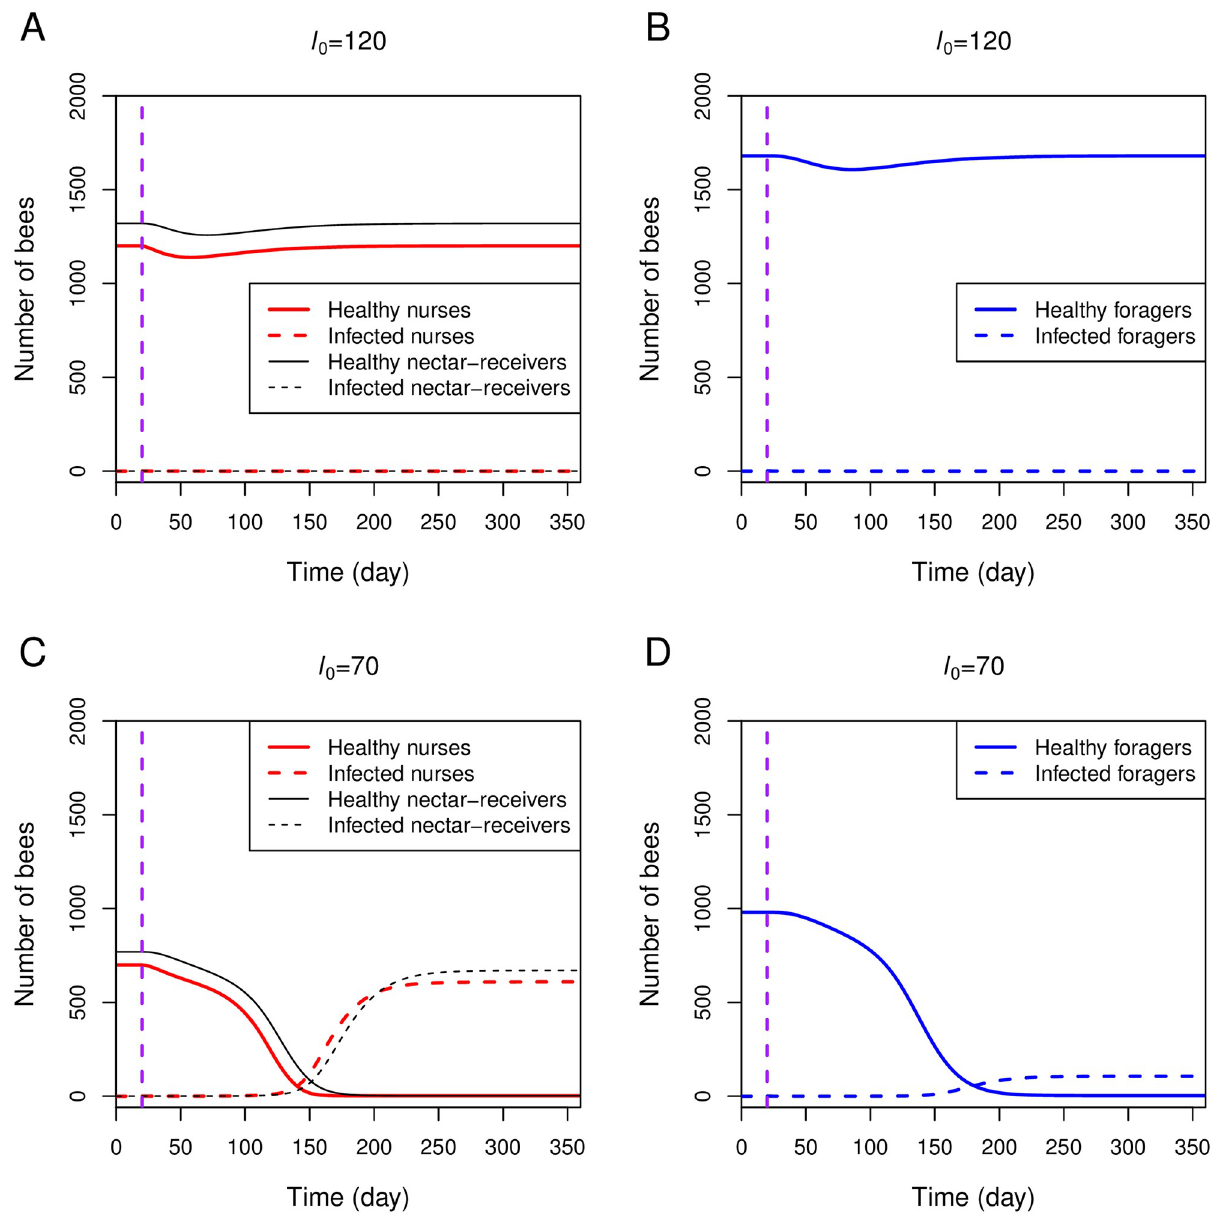
Fig 5. Simulations of the full model. The full model is simulated with parameters listed in Table 1 with l 0 = 120 (panels A and B) and l 0 = 70 (panels C and D). One infected forager returning from nectar-collecting (iF 1 ) is introduced at day 20 (iF 1 (20) = 1) (vertical purple line).